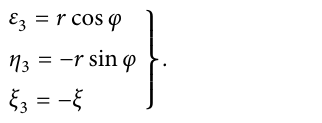
ξ η . (b) Coordinate system r φξ 3 3 3